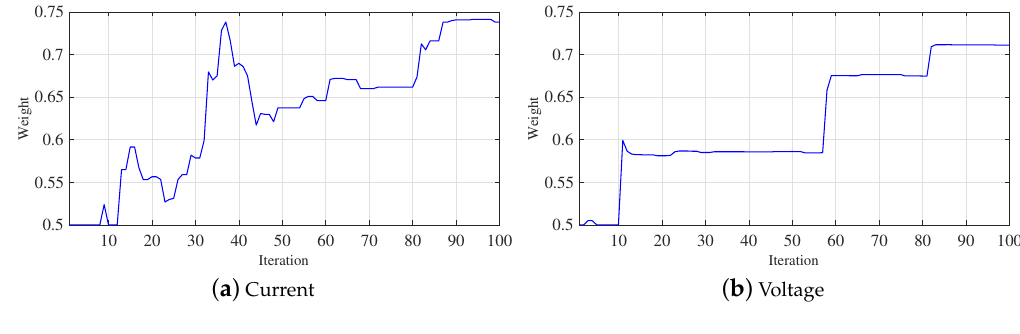
Figure 4. Evolution of inertial weight